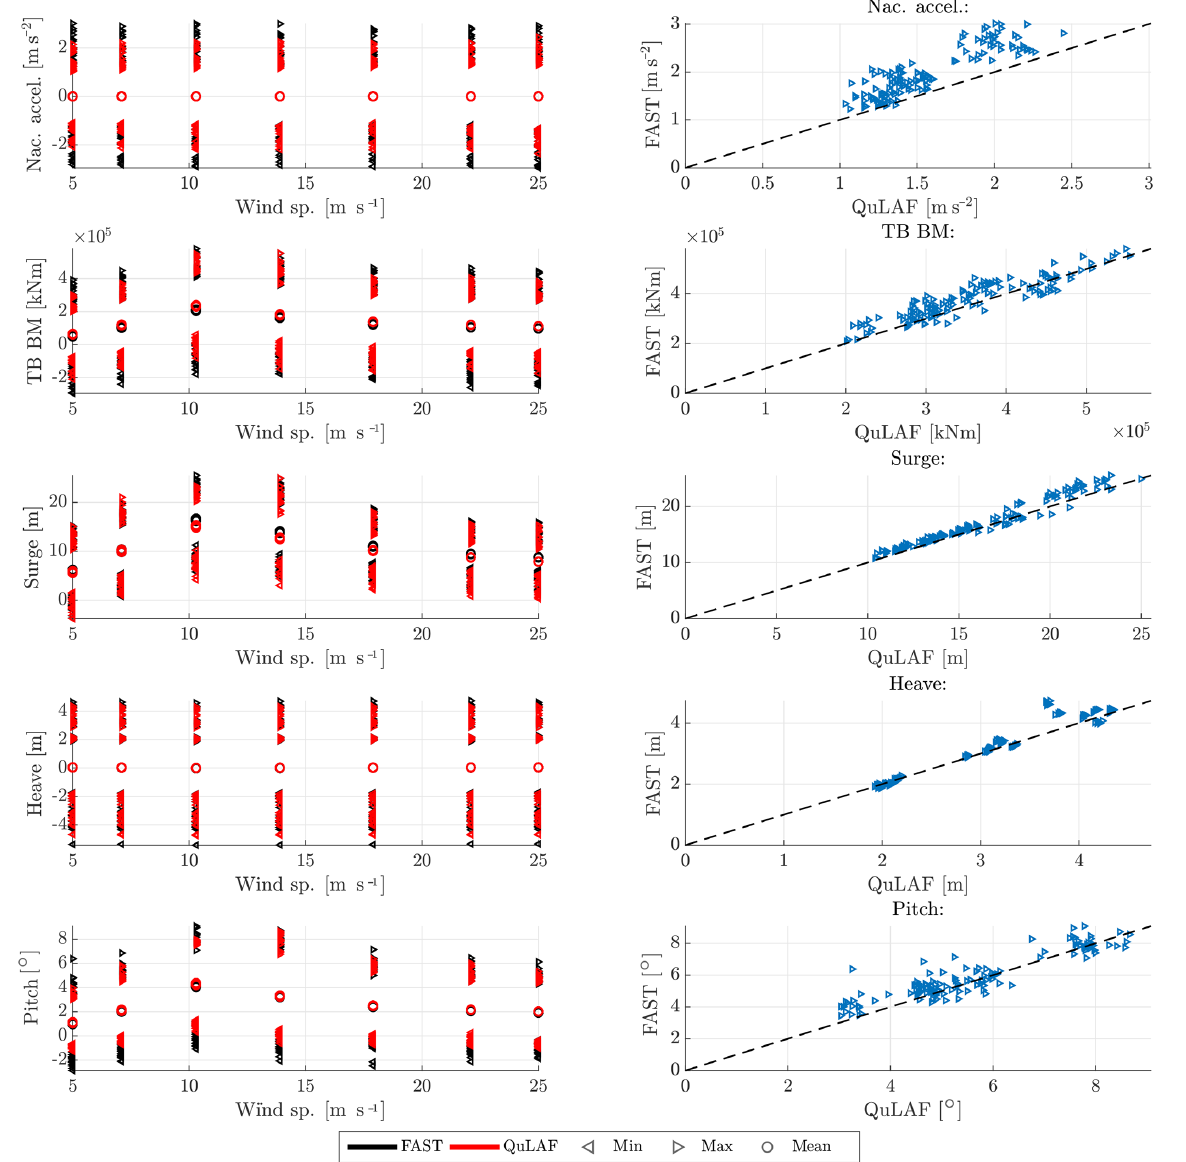
Figure 5. Response to DLC1.6 for FAST and QuLAF. Left: min., max. and mean values for every realization as a function of wind speed. Right: maximum values for FAST as a function of the corresponding maximum values in QuLAF. Table 6. Ratio of max. response (QuLAF / FAST) averaged per wind speed for DLC